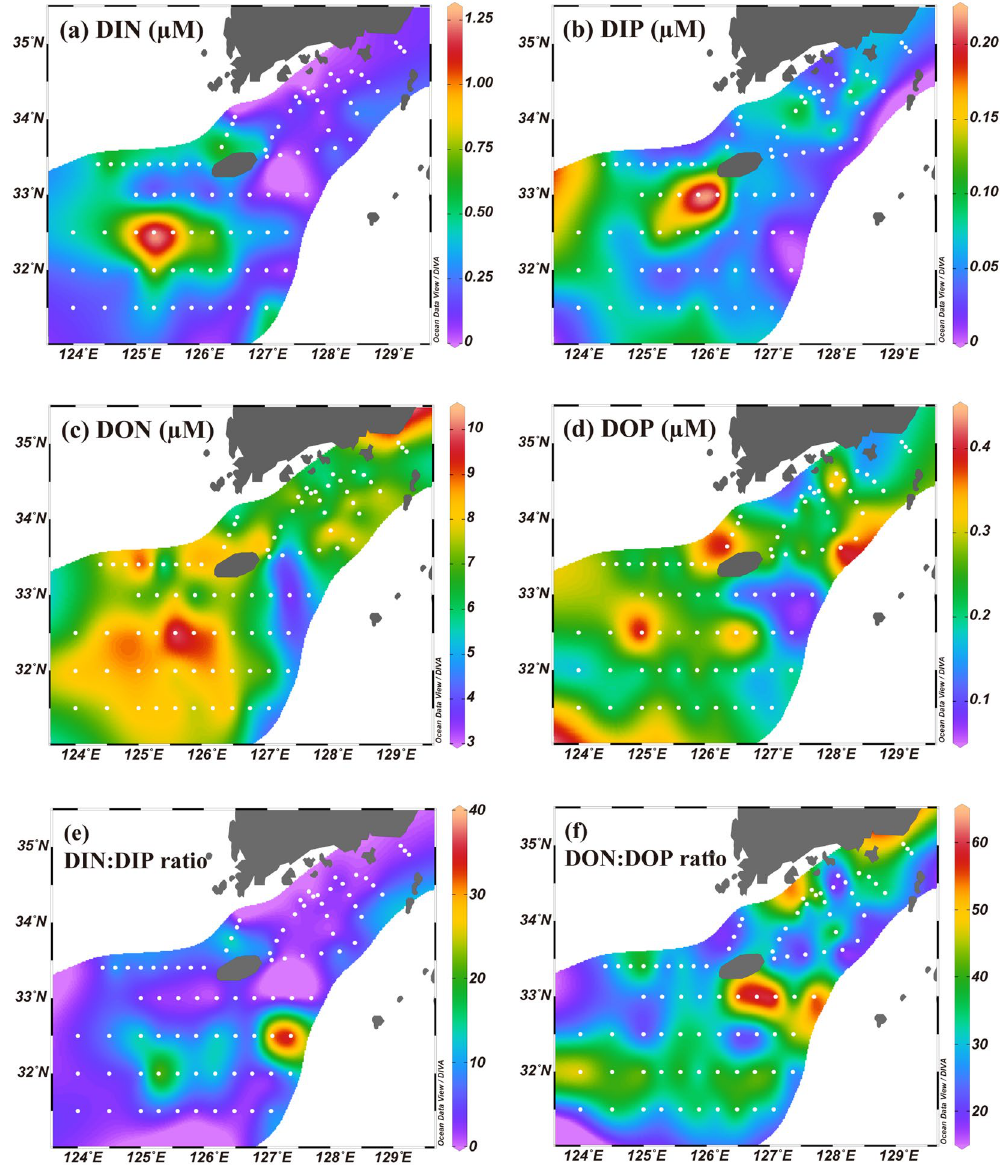
Figure 2. Horizontal distributions of ( a ) DIN, ( b ) DIP, ( c ) DON, ( d ) DOP, ( e ) DIN:DIP ratio, and ( f ) DON:DOP ratio in surface waters of the East China Sea from August 22 to September 6, 2017. The contour maps were created using Ocean Data View software version 5.0.0. (Schlitzer, R., Ocean Data View, odv.awi.de,